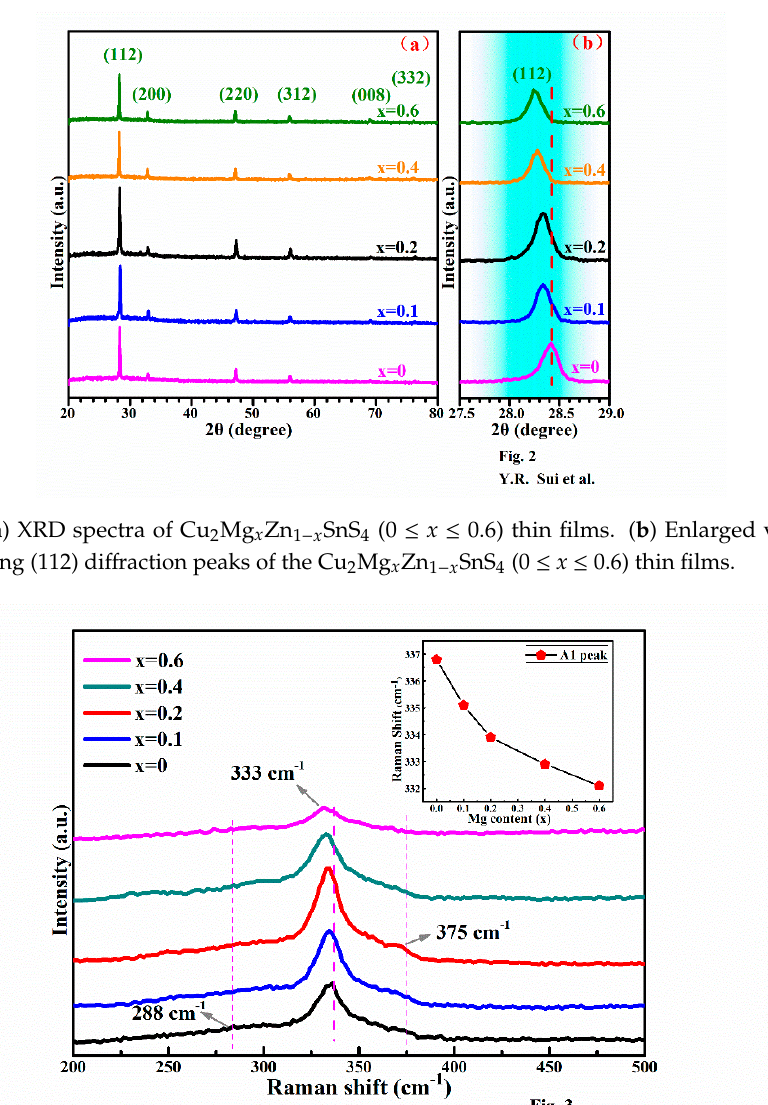
Figure 2. ( a ) XRD spectra of Cu 2 Mg x Zn 1- x SnS 4 (0 ≤ x ≤ 0.6) thin films. ( b ) Enlarged view of the corresponding (112) diffraction peaks of the Cu 2 Mg x Zn 1- x SnS 4 (0 ≤ x ≤ 0.6) thin films.